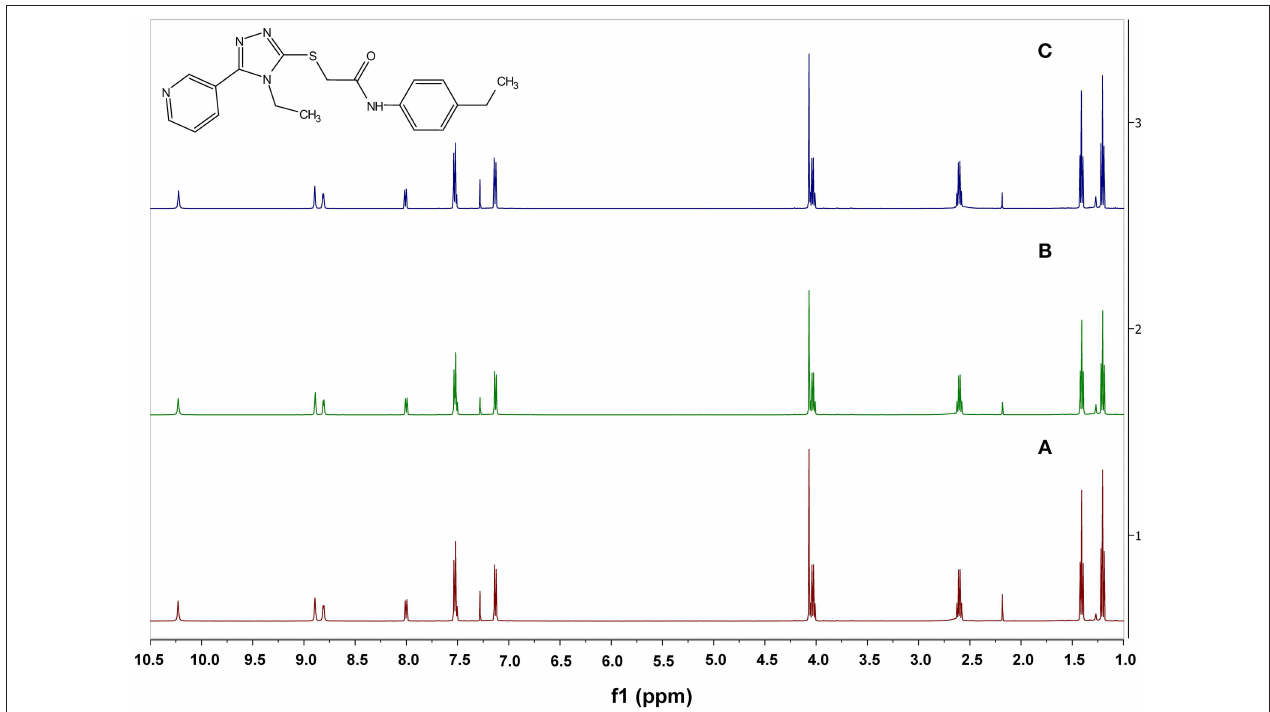
FIGURE 4 | 1 H-NMR spectra of acetone-extracted VUAA-1 samples. (A) . Sample extracted at room temperature. (B) Sample extracted after heating to 200 ◦ C using the induction heating for 4s at 6V. (C) Sample extracted after heated to 500 ◦ C with induction heating for 15s at 6V.